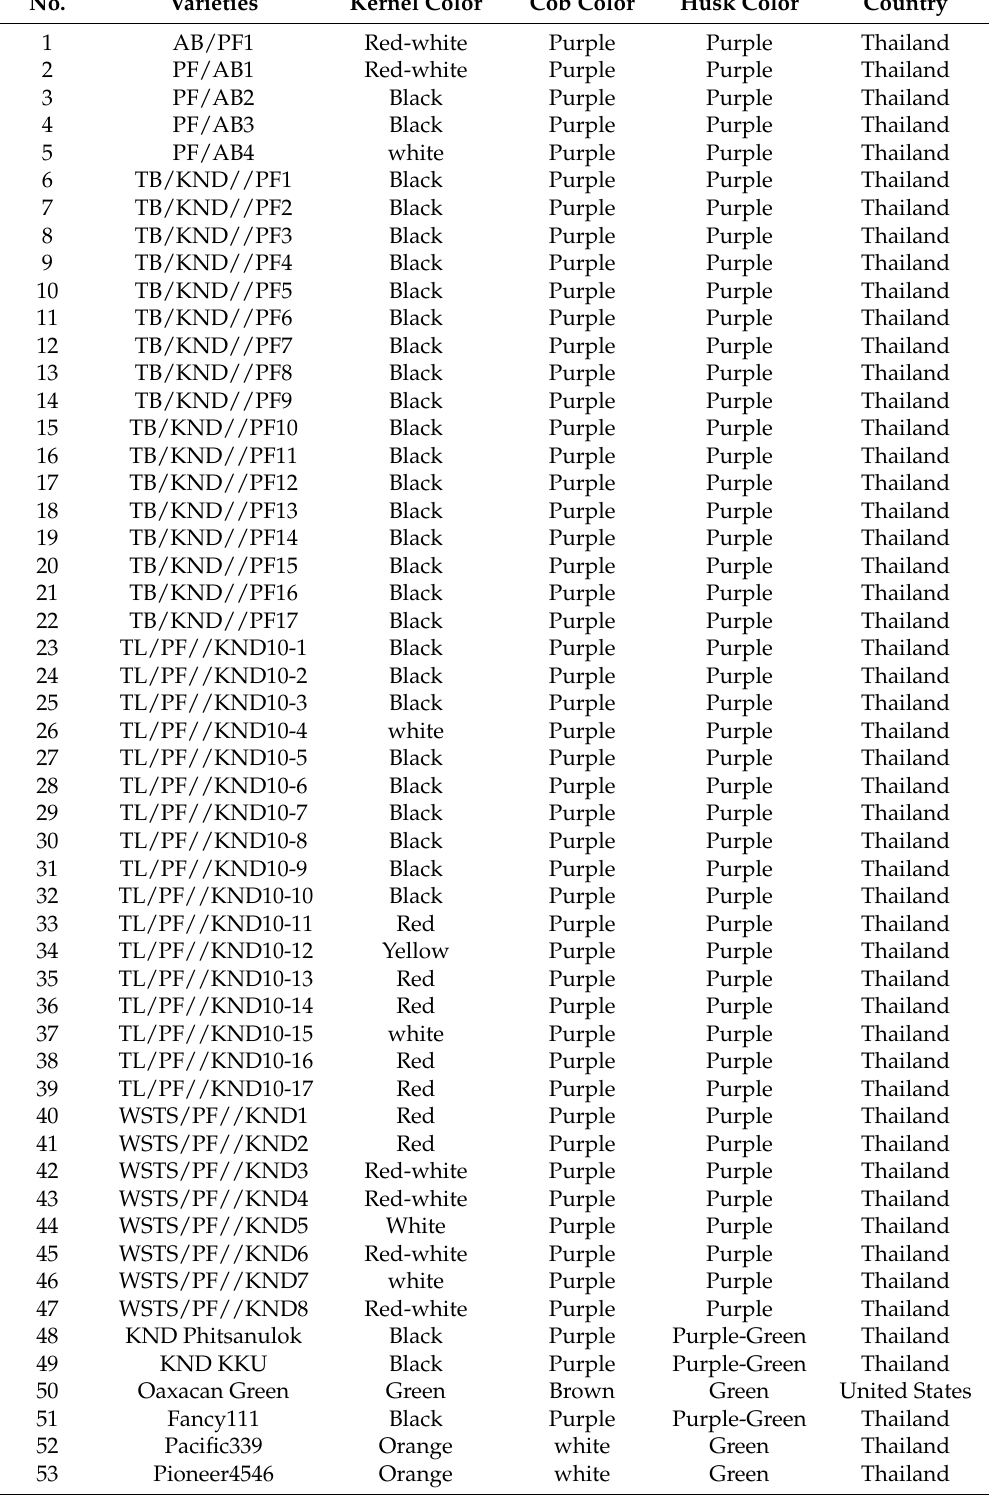
Table 1. Fifty-three genotypes of purple field corn and waxy corn germplasm used in this study.